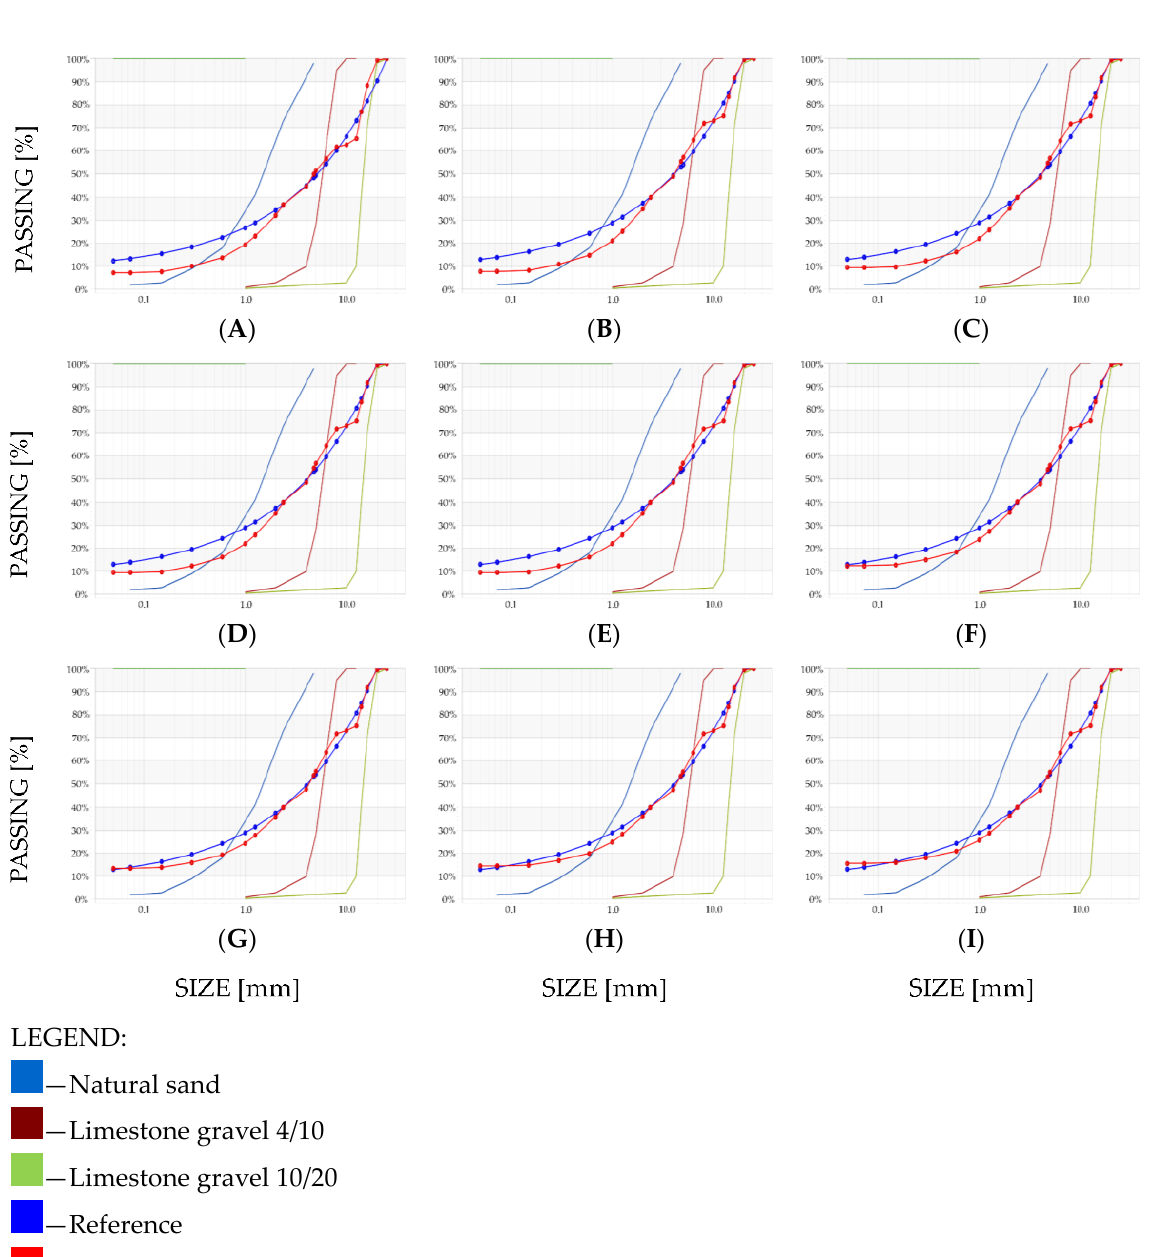
Figure A7. Gradings and fitting curves for Recipe #4—standard mix with plasticizer (lignosulfonate) and superplasticizer (naphthalene) designed according to the Bolomey Method: ( A ) 10 MPa; ( B ) 15 MPa; ( C ) 20 MPa; ( D ) 25 MPa; ( E ) 30 MPa; ( F ) 35 MPa; ( G ) 40 MPa; ( H ) 45 MPa; ( I ) 50 MPa. Legend in the left bottom